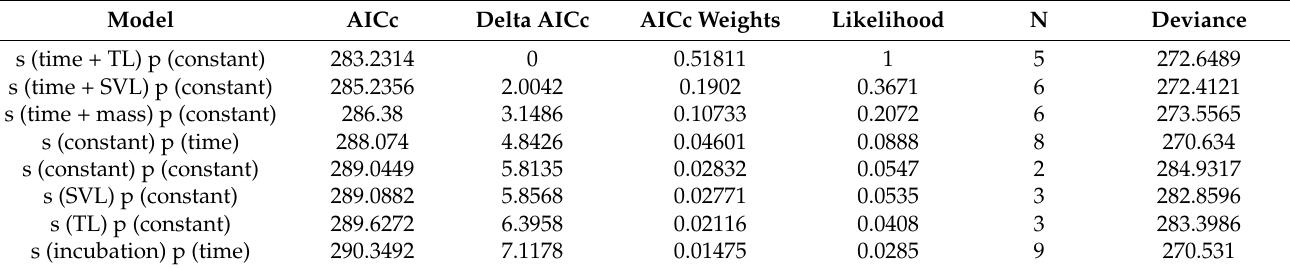
Table 2. Results of survival analyses used to compare rates of apparent survival (s) and recapture (p) for warm-incubated and cold-incubated hatchlings from Dharawal. The candidate models were ranked based on their AICc values and associated AICc weights; models with delta AICc < 2.0 have the greatest statistical support. The table also shows the model likelihood, number of pa- rameters (N), and model deviance. SVL and TL indicate the covariates snout-vent length and tail length, respectively.